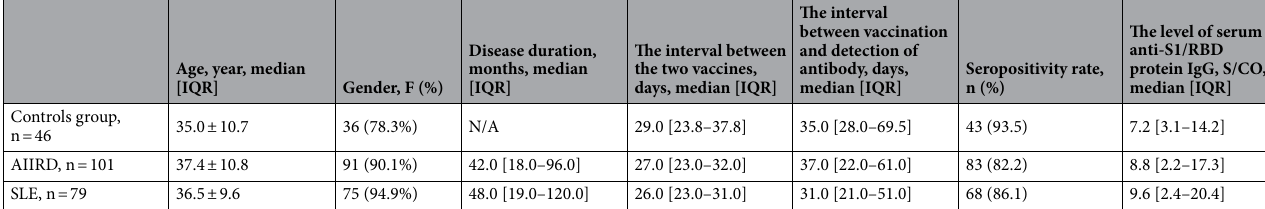
Table 1. Immunogenicity of the inactivated COVID-19 vaccine in patient with AIIRD and controls. No difference by statistical significance in these datas between groups (p > 0.05). AIIRD autoimmune inflammatory rheumatic diseases, SLE systemic lupus erythematosus, N/A not